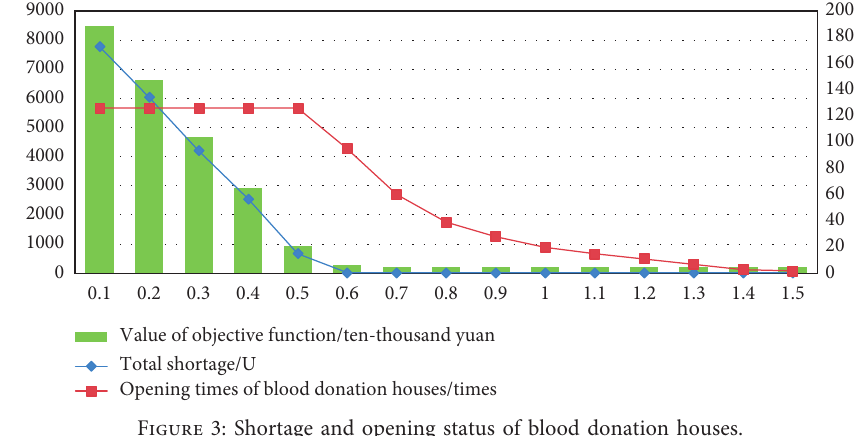
Figure 3: Shortage and opening status of blood donation houses.